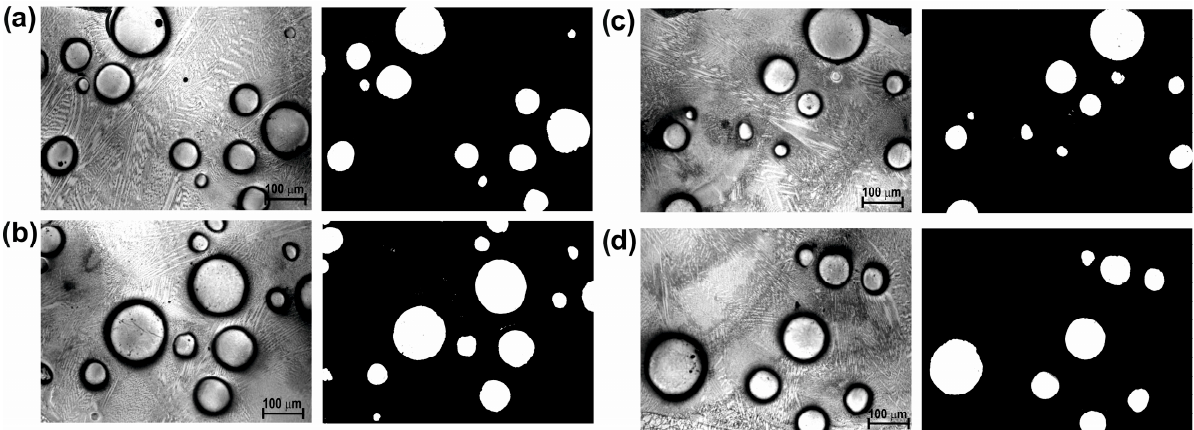
Figure 5. Four selected OM images and their binary images showing the microstructure of the laser-alloyed layer produced with a laser beam power of 1.56 kW: ( a ) area 1, ( b ) area 2, ( c ) area 3, ( d ) area 4.